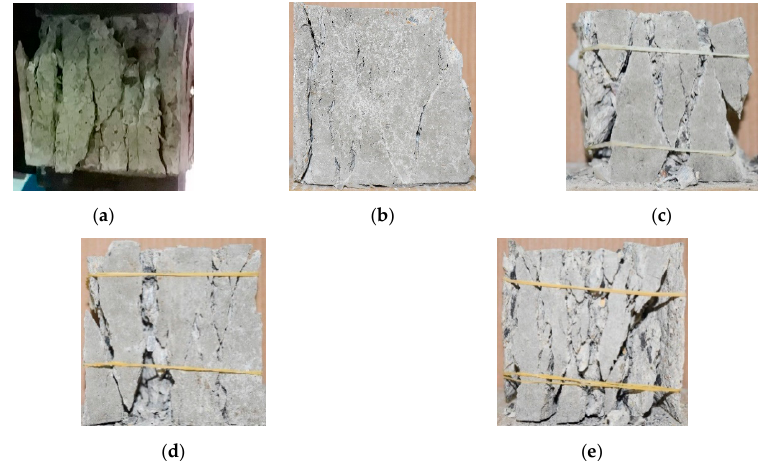
Figure 4. Failure forms of steel slag concrete (SSC). ( a ) 0.00:1; ( b ) 0.25:1; ( c ) 0.50:1; ( d ) 0.75:1; ( e ) 1:1.